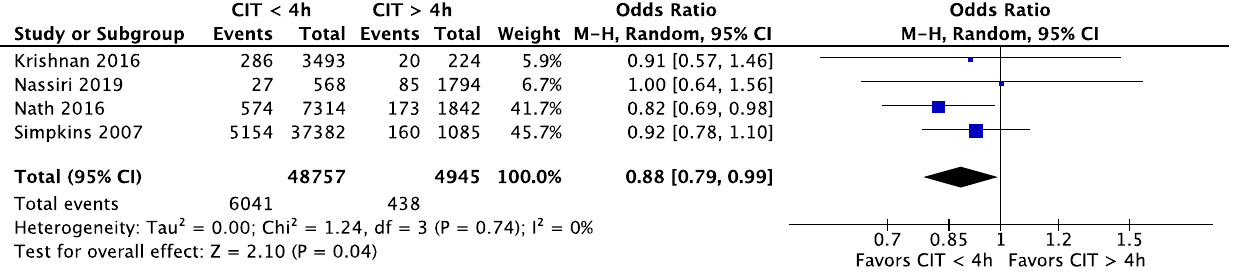
Figure 7. Five-year graft survival for CIT shorter and longer than 4 h. CIT: cold ischaemia time.